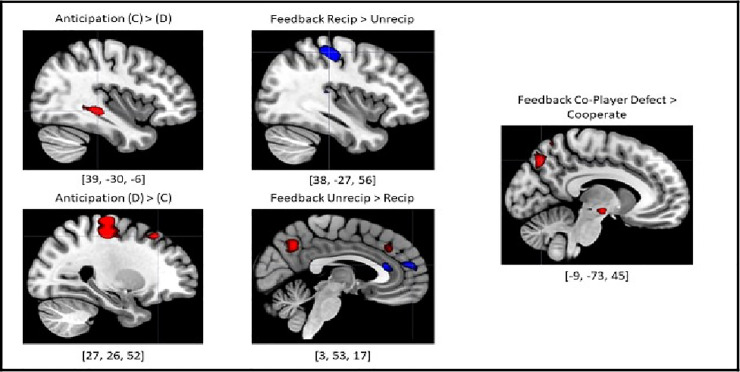
BOLD activity illustrating direct comparison contrasts within-phase.The most salient finding was the activation of the precuneus, involved in self-referential processing, during aversive social outcomes regardless of context (monetary vs social). This result also supports the precuneus’s potential role in conflict monitoring and social adapation in response to negative outcomes. All results for these contrasts were thresholded at t(29) = 3.40, p < .001 uncorrected voxel-wise threshold; FWE-corrected cluster-wise threshold determined by SPM12. (Red = Human Game, Blue = Computer Game, C = Cooperate, D = Defect). Ex. [42, –48, 42] = peak voxel MNI coordinates.